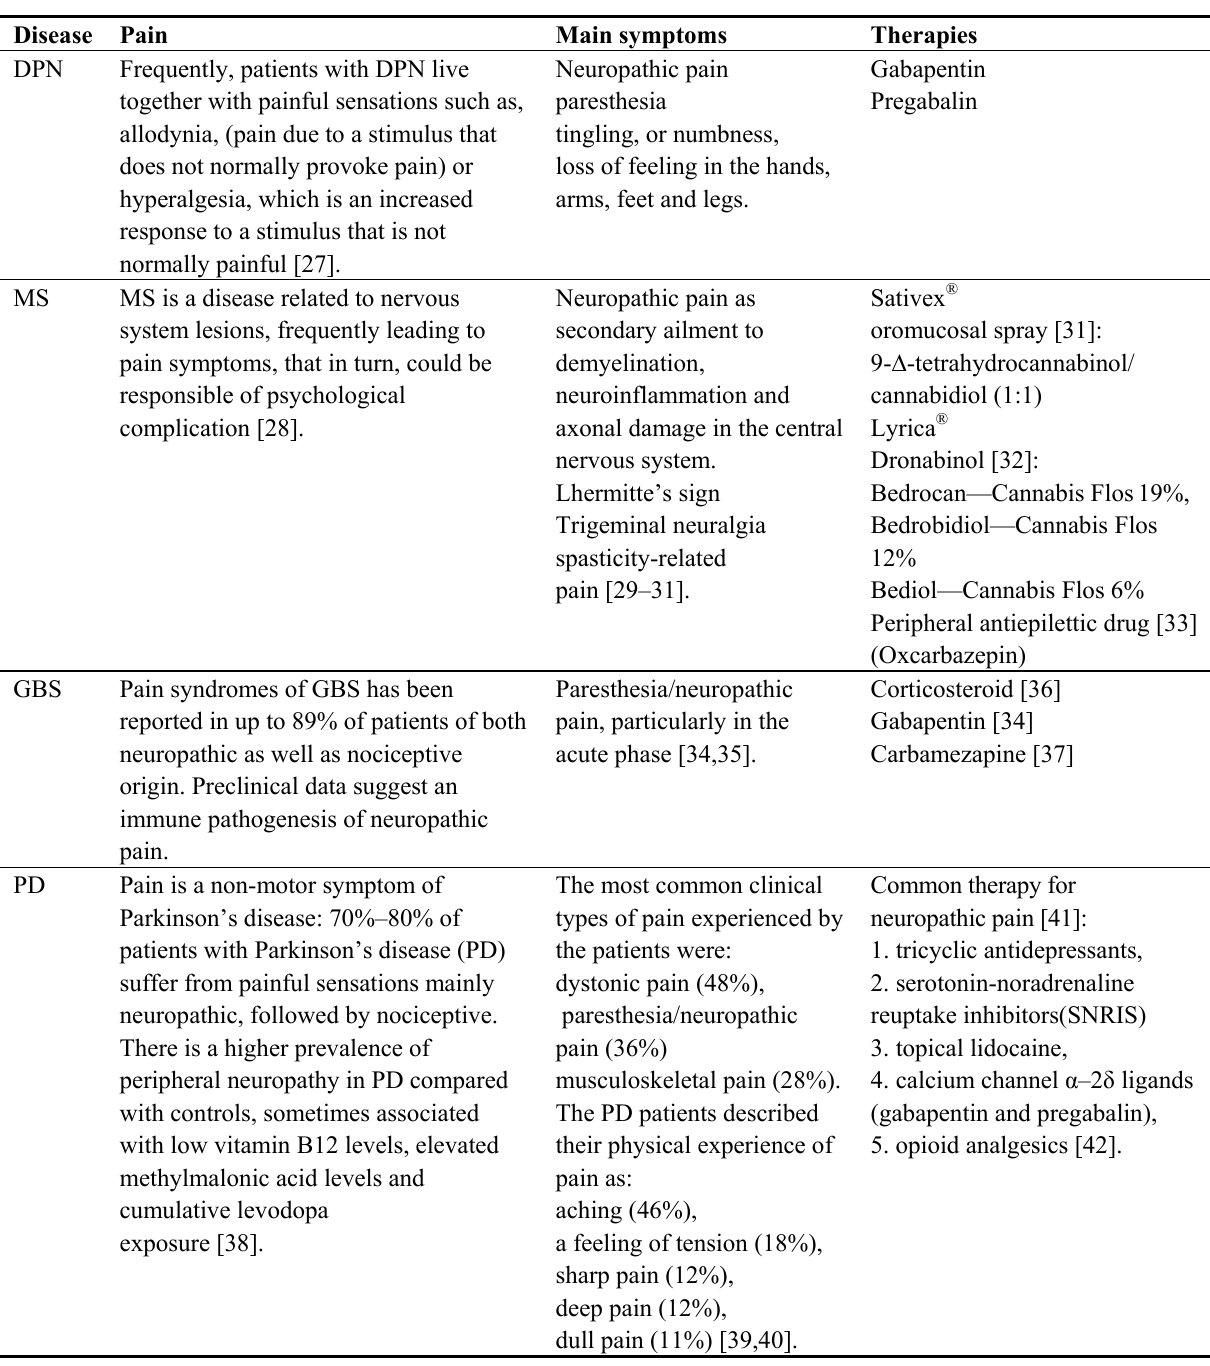
Table 1. Comparative therapies to treat NP associated to DPN as well as to neurodegenerative